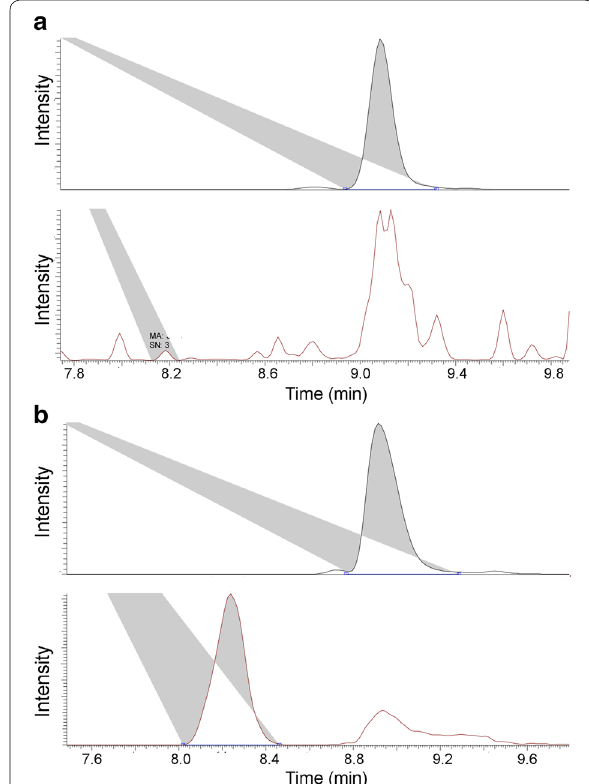
Fig. 4 LC–MS/MS MRM result for chondroitin control and N -glycolyl chondroitin sample. a Chondroitin control has a clear peak (MRM transition pair 572/396) for CN but no peak for Gc-CN (588/412). b N -glycolyl chondroitin sample both have clear peaks (572/396) for chondroitin and Gc-CN